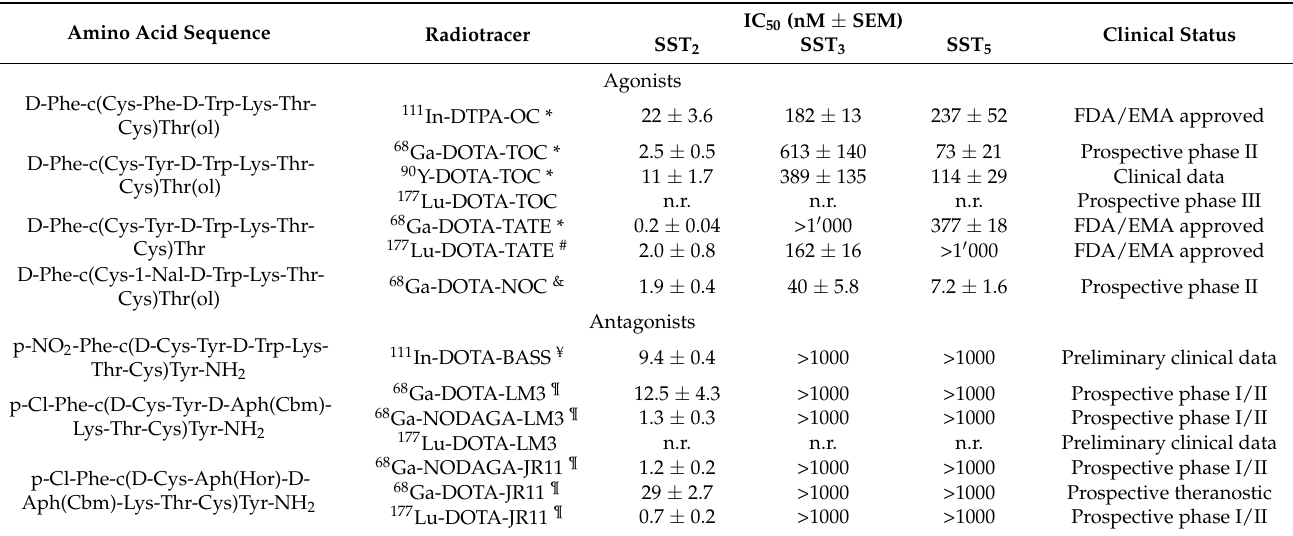
Table 1. Somatostatin-based radiotracers. Affinity data (IC 50 = half maximal inhibitory concentration) and clinical